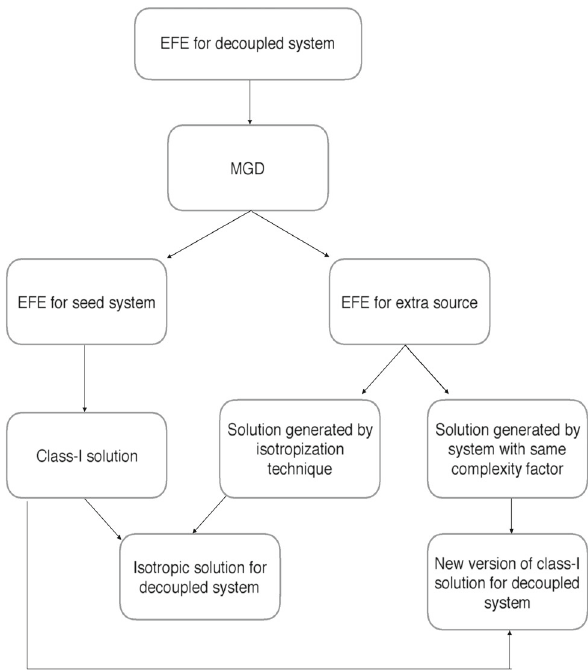
Fig. 1 The flow chart shows the systematic approach adopted for gen- erating the solution in the context of